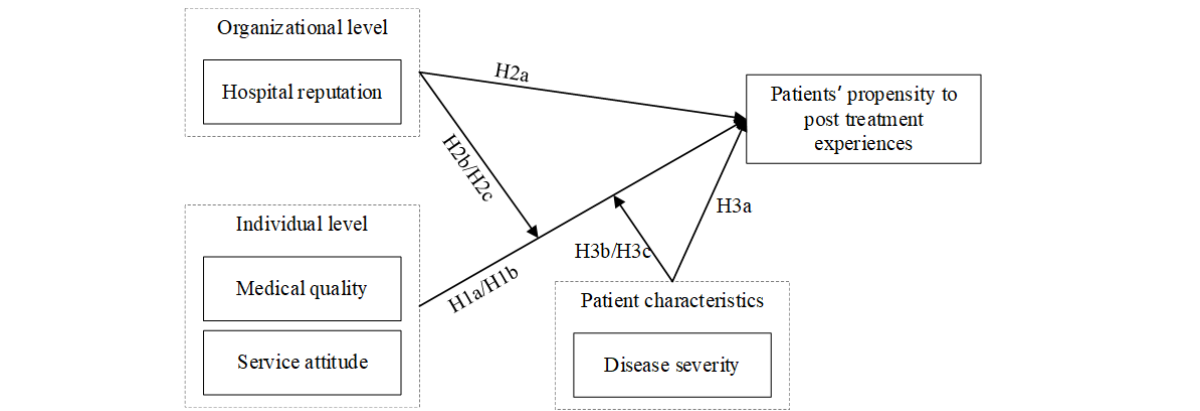
Figure 1. Conceptual